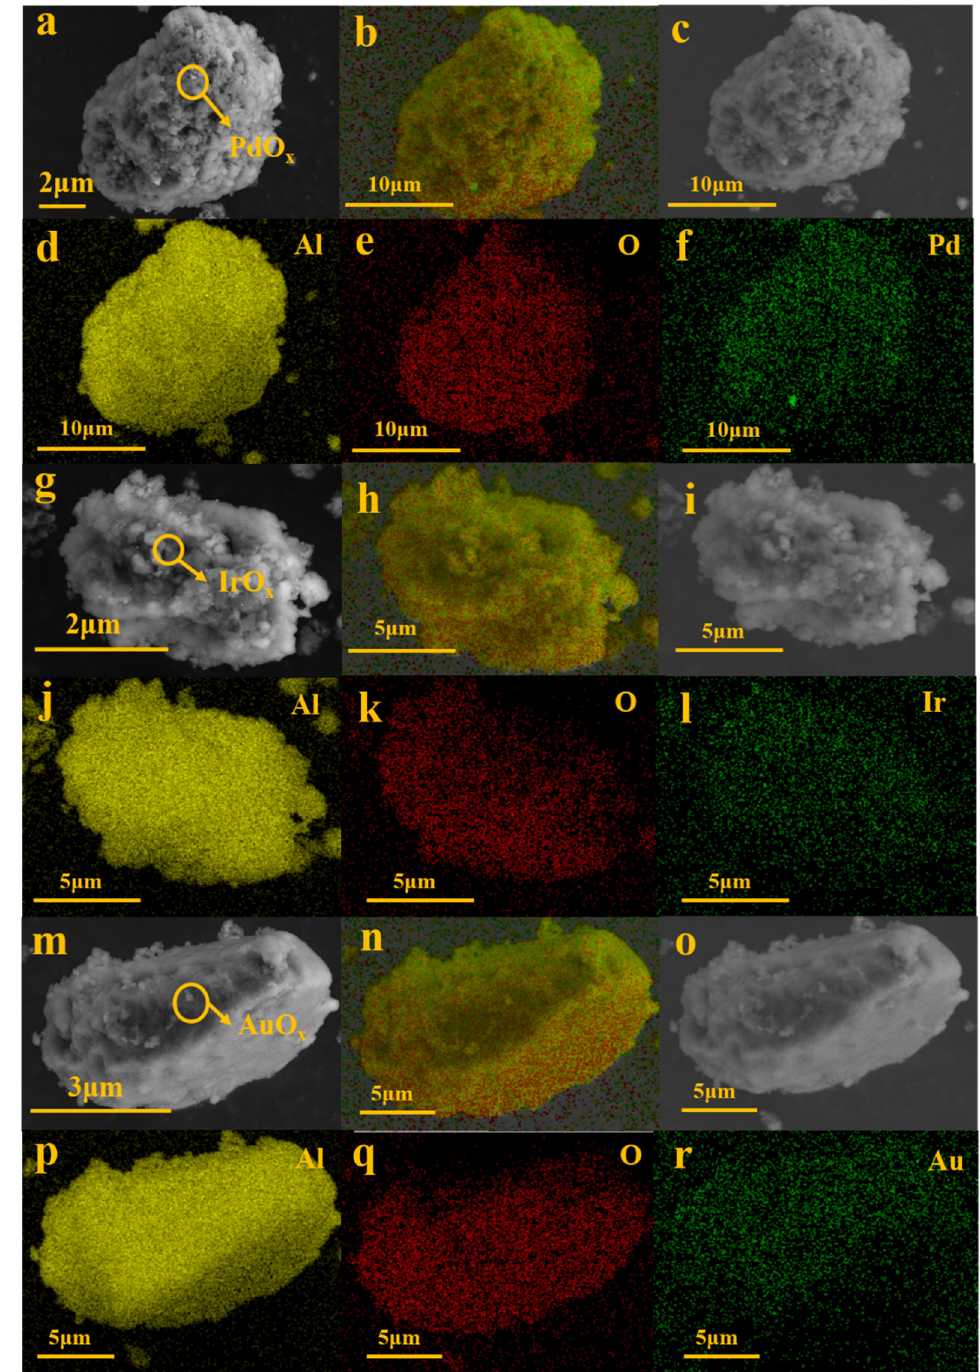
Figure 5. FE-SEM images of ( a ) Pd/ γ -Al 2 O 3 , ( g ) Ir/ γ -Al 2 O 3 , ( m ) Au/ γ -Al 2 O 3 ; EDS elemental mapping of (b, d – f ) Pd/ γ -Al 2 O 3 , (h, j – l ) Ir/ γ -Al 2 O 3 , (n, p – r ) Au/ γ -Al 2 O 3 derived from the SEM images of ( c ), ( i ), and ( o ), respectively.